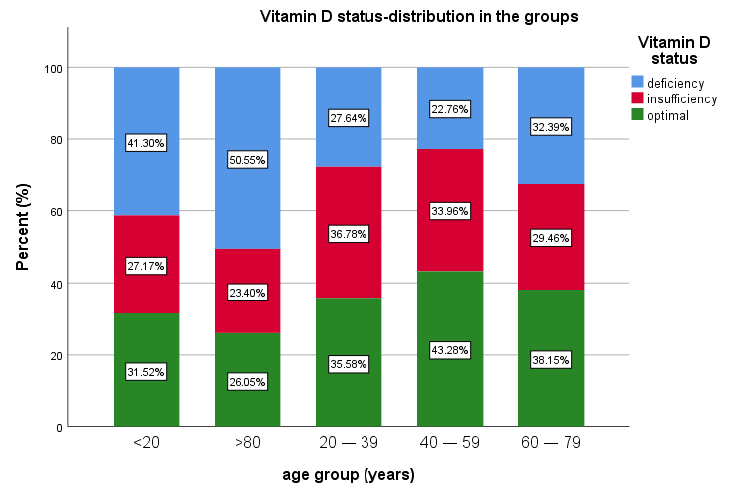
Figure 3. Vitamin D status and age group distribution.